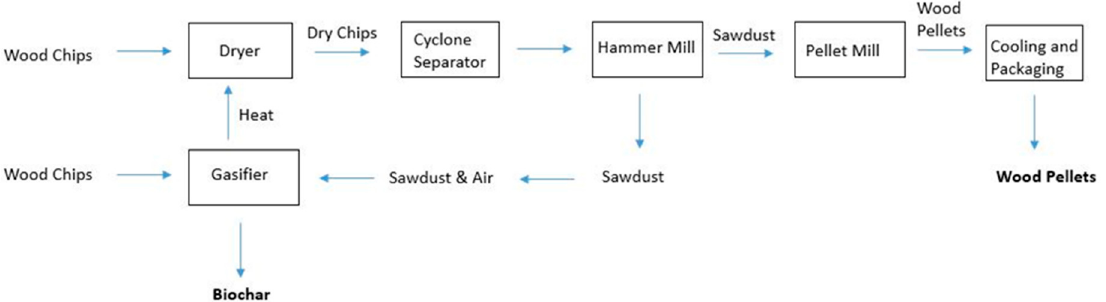
Figure 3. Schematic diagram of process heat from gasification with pellet and biochar production.